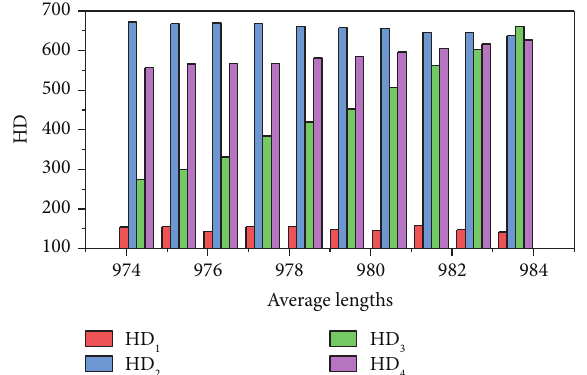
Figure 8: Comparison of the average lengths of the simplifications.